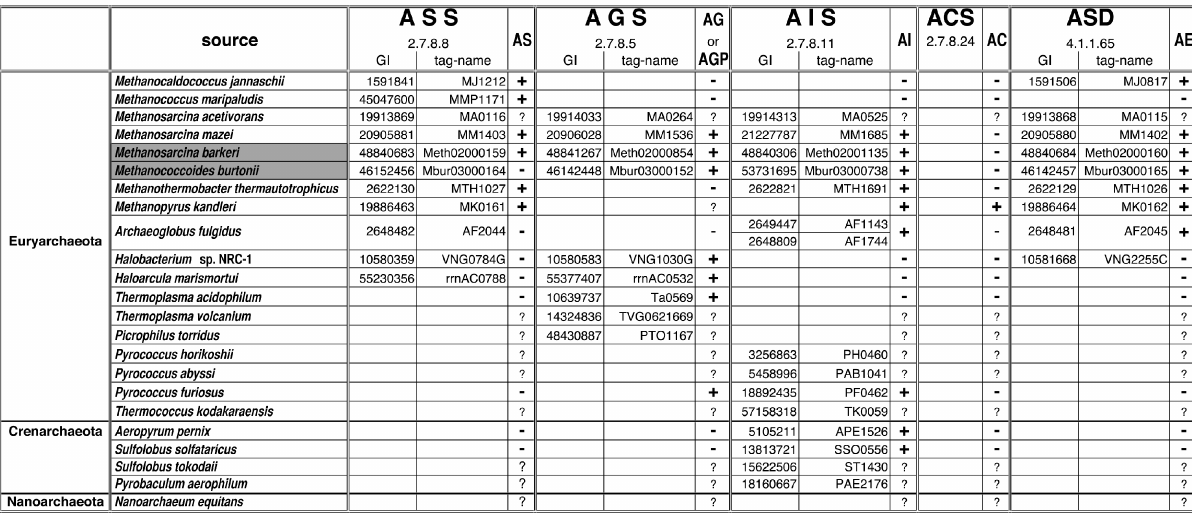
Figure 2. List of candidateenzymes for polar lipidsynthesis.The classificationsand the sources are shown in the firstand second columns, respec- tively. The complete genome sequences of the sources, except for those of M. barkeri and M. burtonii, are available. A candidate enzyme obtained by the database search is indicatedby the GI number and the gene tag-namefor each archaeal species. A blank indicatesthat the correspondingen- zymewas notdetectedfromthesource. The presenceor absenceof a polarlipidinthemembraneisshown by ‘+’, or ‘–’. The symbol,‘?’, indicates that the lipid content of the species has not been examined. Information about lipid distributions was obtained from Kates 1978, De Rosa et al. 1986, Ferranteet al. 1990, Koga et al. 1993, 1998, Nishiharaand Koga 1995, Ihara et al. 1997, Sprottet al. 1997, 2003, Moriiet al. 1999, Nishihara et al. 2002, Shimada et al. 2002 and Nichols et al. 2004. The lipid composition of A. fulgidus is our unpublished data. Abbreviations: ASS = archaetidylserine synthase; AGS = archaetidylglycerol synthase; AIS = archaetidylinositol synthase; ACS = archaetidylcholine synthase; ASD = archaetidylserine decarboxylase; AS = archaetidylserine; AG = archaetidylglycerol; AGP = archaetidylglycerolphosphate; AI = archaetidyl- inositol; AC = archaetidylcholine; and AE =